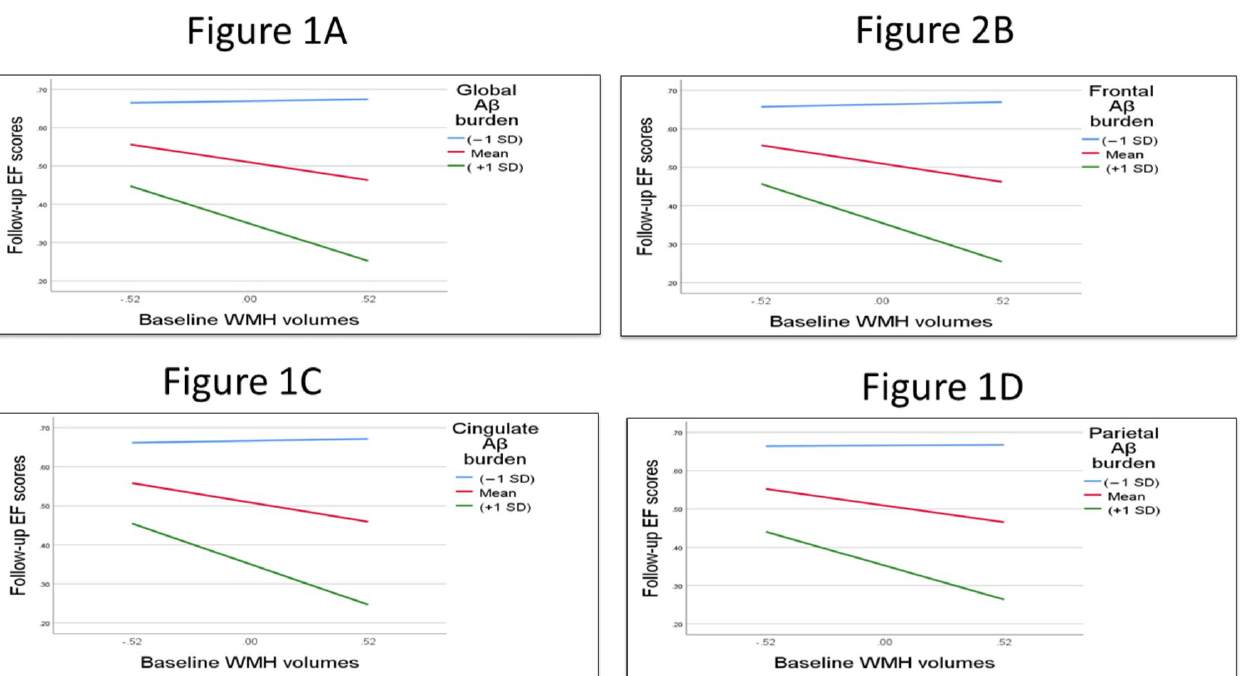
Figure 1. Longitudinal EF performance at low ( − 1 SD), moderate mean (0 SD) and high (1 SD) levels of baseline global and regional A β burden and